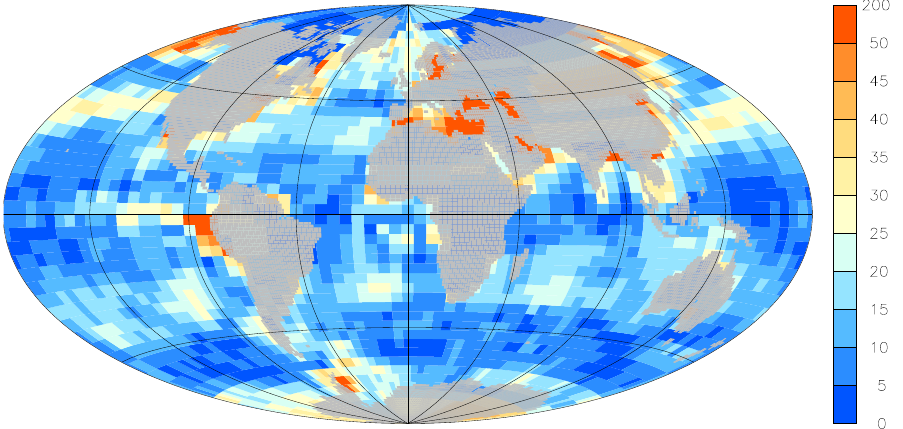
Fig. 4. Amplitude of the seasonal cycle of surface-ocean CO 2 par- tial pressure (µ atm ) estimated by fitting the diagnostic scheme to the SOCAT data (run SFC ). The amplitude is given as temporal standard deviation of the 1997-2009 monthly mean p CO 2 m at each pixel.